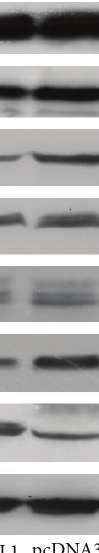
Figure 3: Cell cycle regulatory proteins expression analysis in HepG2 cells treated without (control) and with LEPREL1 for 72